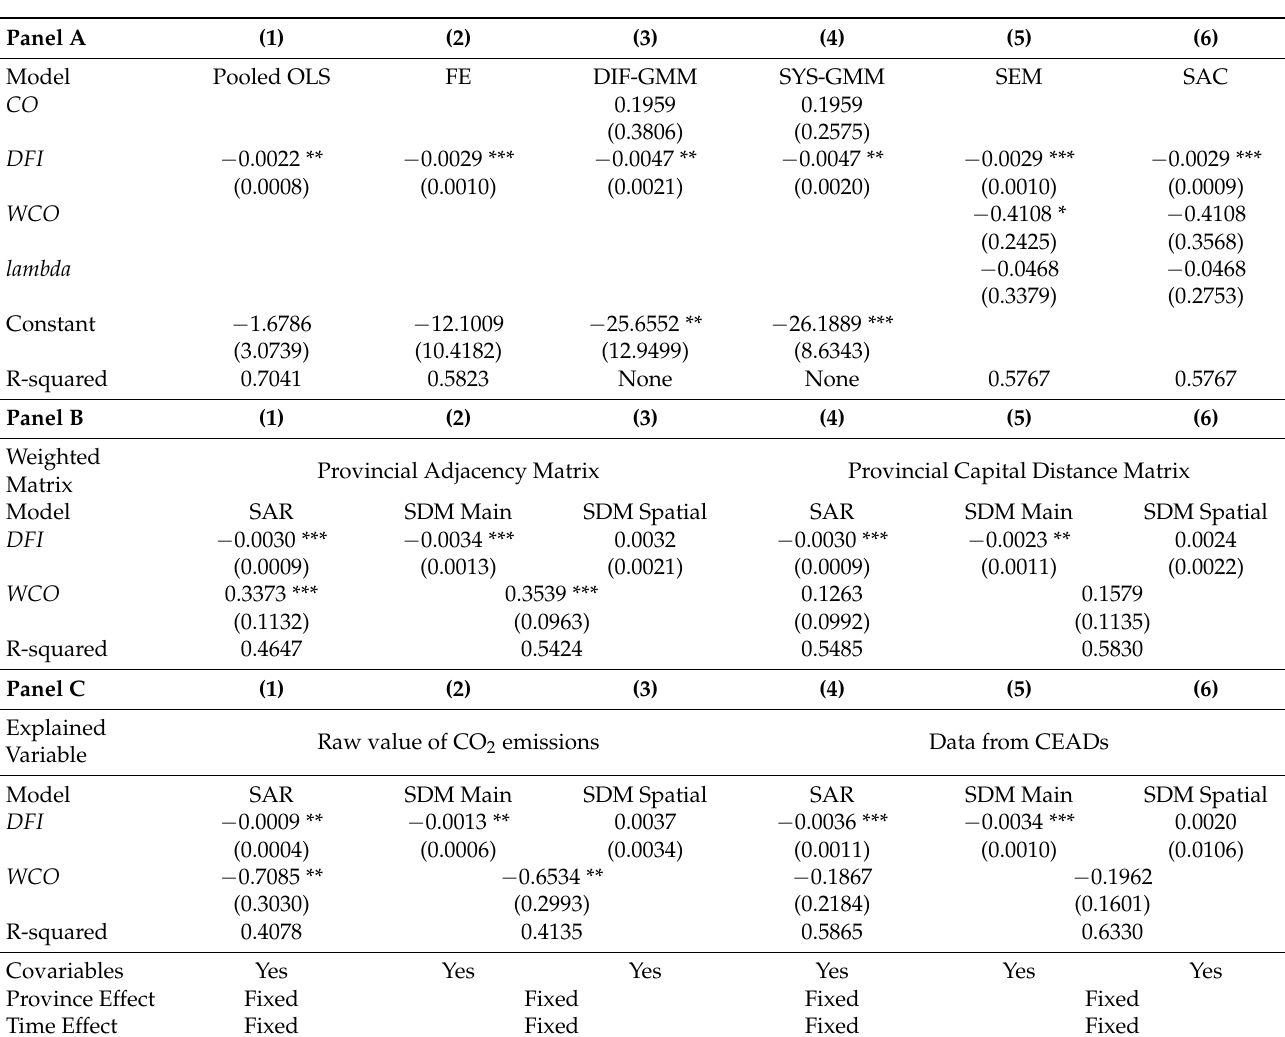
Table 6. Robustness